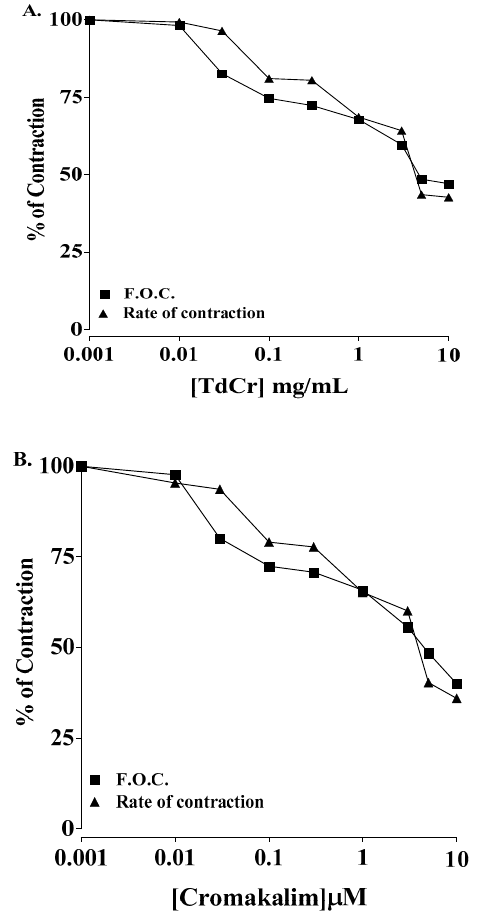
Figure 12. Concentration-response curve presentation the inotropic and chronotropic effects of ( A ) TdCr and ( B ) cromakalim on spontaneous contractions of paired atrial preparation of a rabbit. Values shown as mean ± SEM, n = 5.